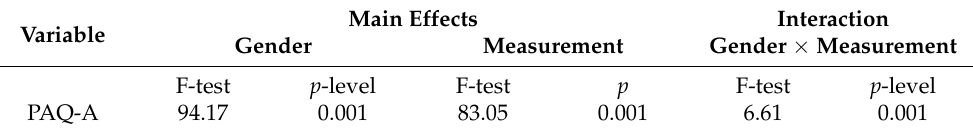
Table 1. Results of the factorial analysis of variance for repeated measurements. Variable